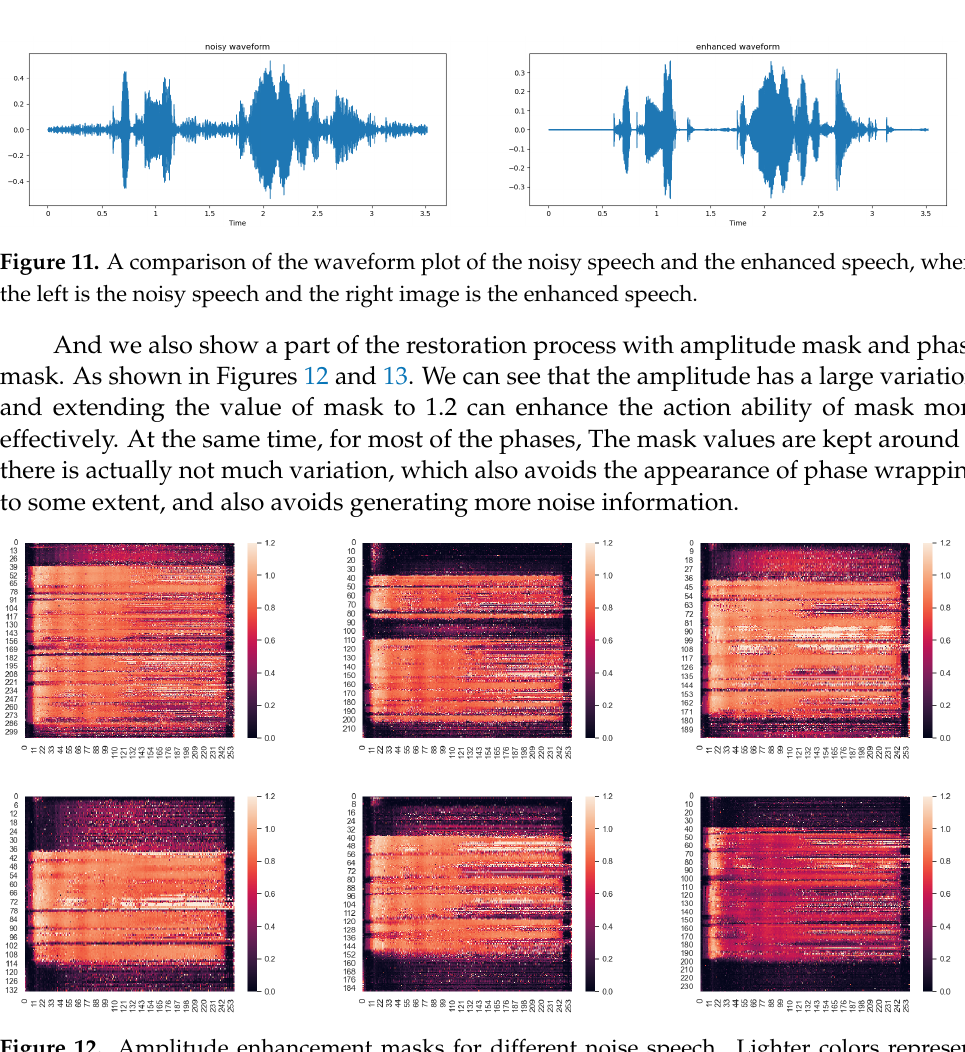
Figure 12. Amplitude enhancement masks for different noise speech. Lighter colors represent larger values.